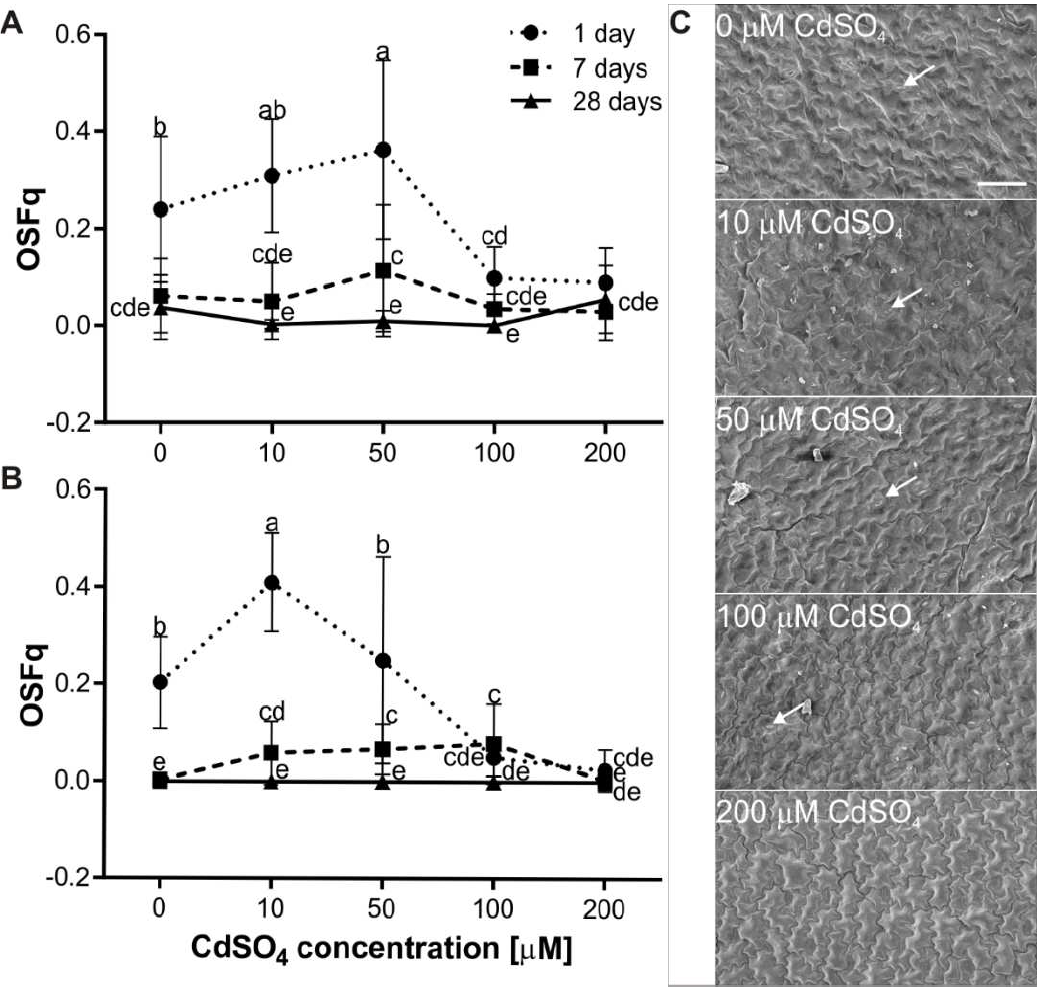
Figure 7. The response of stomatal opening during the experiment and Cd-treatment. OSFq on the adaxial ( A ) and abaxial ( B ) surfaces of pea leaves after 1, 7 and 28 days of Cd treatment. Each value is the mean of three replicates ±SD. Different letters represent significant differences ( p < 0.05). Representative images of the adaxial surface of the pea leaf after 1 day of Cd-treatment. The open stomata is indicated with an arrow ( C ). Scale bar: 50 μm.